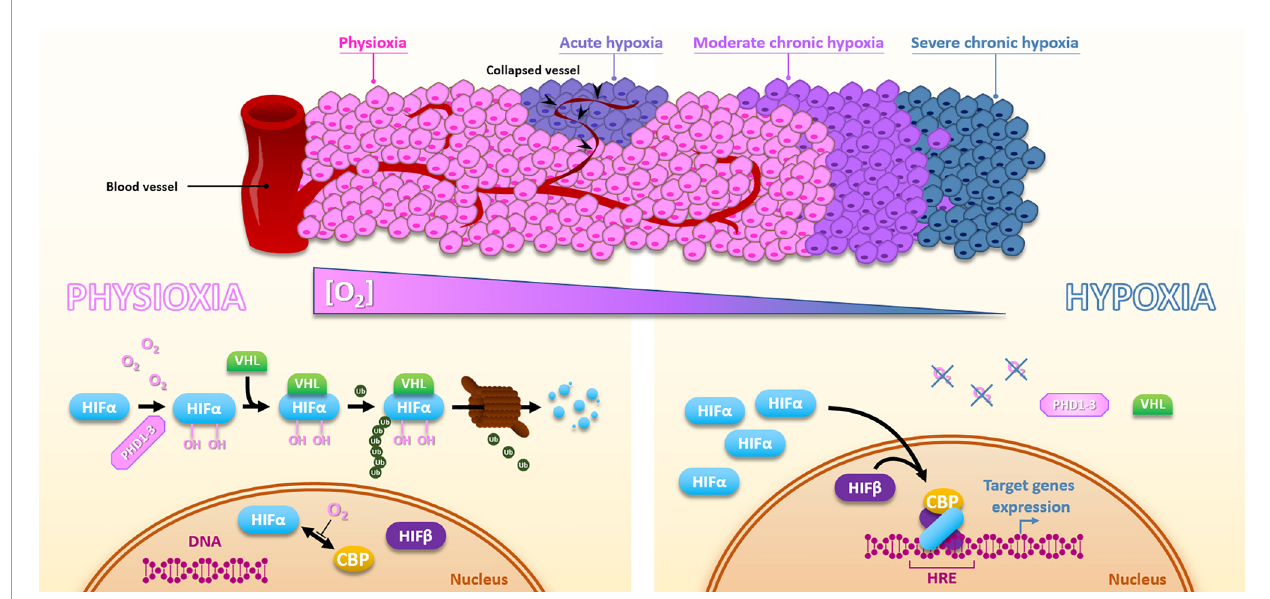
FIGURE 2 | Hypoxia and HIFs regulation. Due to the distance to the blood vessels, cancer cells are well oxygenated or under moderate to severe chronic hypoxia. In addition, vessels collapse can cause sporadic acute hypoxic areas. Under physioxia, HIF a is hydroxylated by PHDs, poly-ubiquitinylated via VHL, and then degraded by the proteasomal way. Oxygen also inhibits HIF a -CBP interaction. Inversely, hypoxia inactivates PHDs, HIF a is subsequently stabilized, translocates into the nucleus, and forms a complex with HIF b and CBP, which activates HREs-containing genes